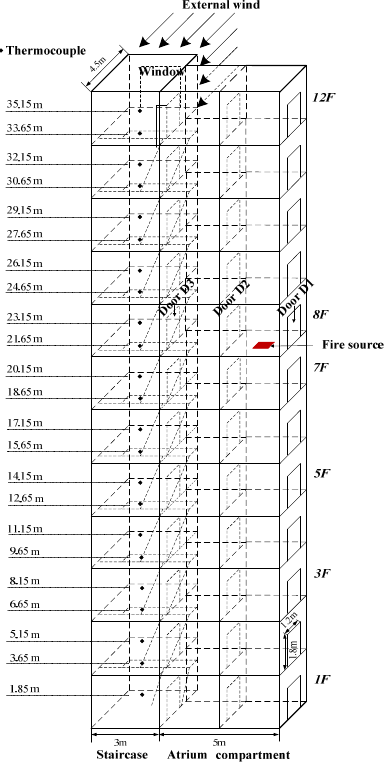
Figure 1. Schematic view of model building. In the FDS user’s guide, a D ∗ / δ x criterion has been used for assessing the grid resolution. δ x is the nominal size of a mesh cell, and D * is a characteristic fire diameter. D * is calculated by: